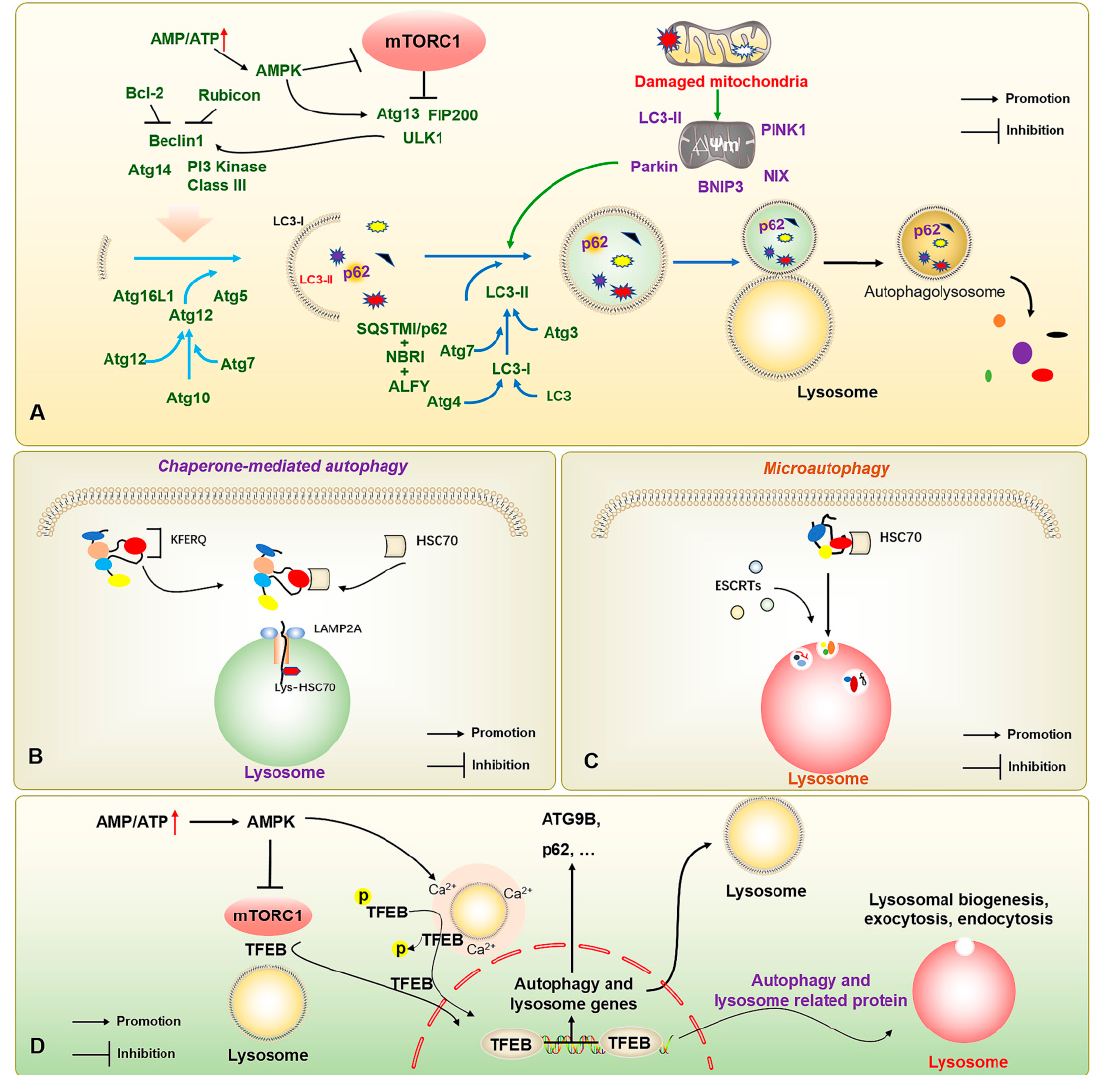
Figure 1. The molecular mechanisms of macroautophagy, chaperone ‐ mediated autophagy, microautophagy, and autophagy ‐ lysosome ‐ associated transcription factors. ( A ) The increased AMP/ATP ratio activates AMPK to inhibit mTOR; and activates the ULK1 complex (ULK1 ‐ ATG13 ‐ ATG101 ‐ FIP200) to further induce the completion of autophagy process through a series of autophagy ‐ related proteins, including PI3K ‐ ATG2 ‐ ATG18 complex, and ATG5 ‐ ATG12 ‐ ATG16L1 complex. ( B ) HSC70 realizes the degradation by recognizing the KFERQ motif and transporting the substrate protein into lysosomes through LAMP2A. ( C ) HSC70 binds to KFERQ ‐ carrying proteins and degrades the substrates through ESCRT complexes for accomplishing substrate transport and lysosome phagocytosis. ( D ) The increased AMP/ATP ratio activates AMPK for inhibiting mTOR and regulating the lysosomal Ca 2+ microenvironment to promote the nucleus translocation of TFEB after dephosphorylation, thereby binding autophagy ‐ and lysosome ‐ related genes, and enhancing autophagic flux. The ↑ in red color represents the increased AMP/ATP ratio; the → and ┤ in black color represent the promotion and inhibition,